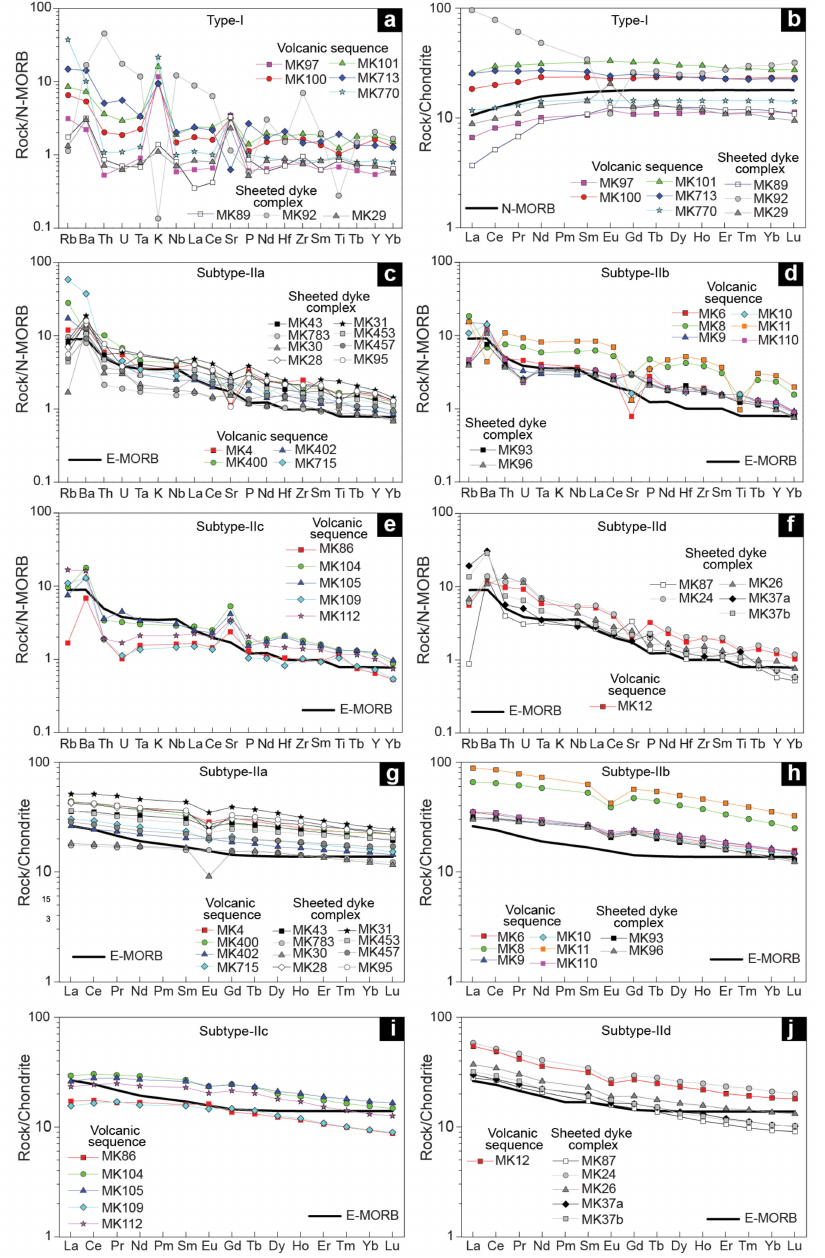
Figure 9. N-MORB (normal-type mid-ocean ridge basalt)-normalized incompatible element patterns ( a , c – f ) and chondrite-normalized rare earth element (REE) patterns ( b , g – j ) for volcanic and subvolcanic rocks from the sheeted dyke complex and volcanic sequence of the Band-e-Zeyarat ophiolite. Normalizing values and N-MORB and E-MORB compositions are from Sun and McDonough